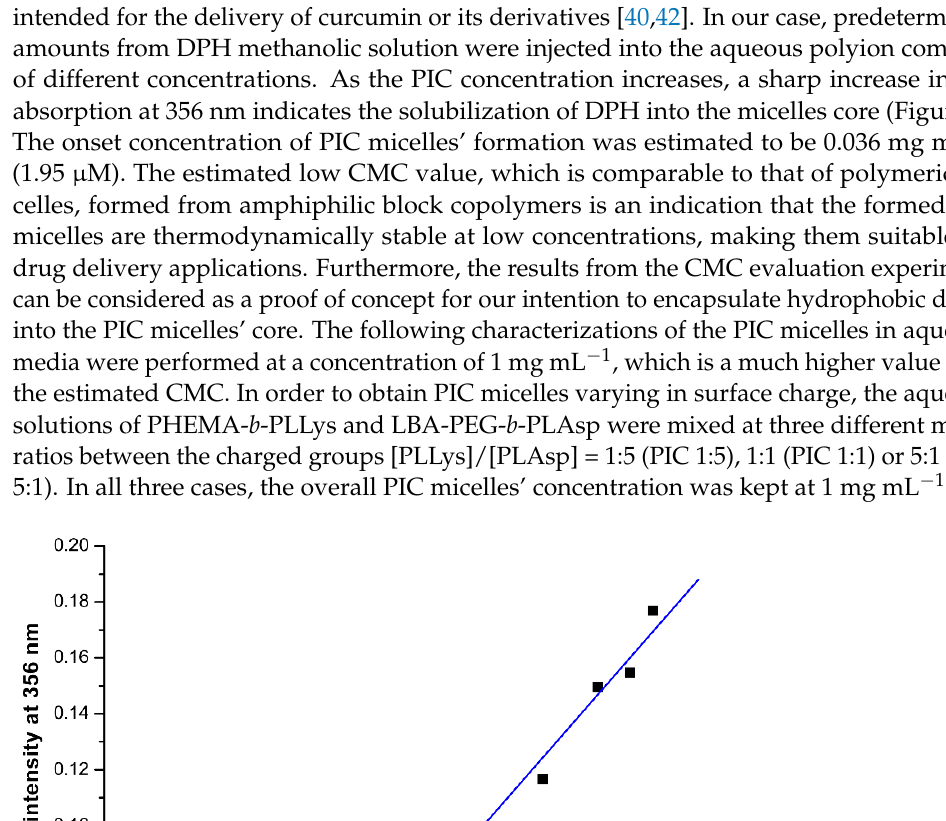
( b ) Figure 3. Size-distribution curves ( a ) and zeta potentials ( b ) obtained from DLS measurements of 1 mg mL − 1 aqueous micellar dispersions of polyion complex micelles prepared at different molar ratios between the positively and negatively charged groups: PIC 1:5 (d = 95.85 nm, PdI: 0.295, ζ = − 21.64 mV), PIC 1:1 (d = 90.02 nm, PdI: 0.318, ζ = − 4.41 mV), PIC 5:1 (d = 79.14 nm, PdI: 0.109, ζ = 10.93 mV).